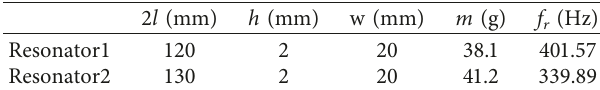
Table 1: Parameters of the finite beam. Table 2: Parameters and resonance frequency of beam-like